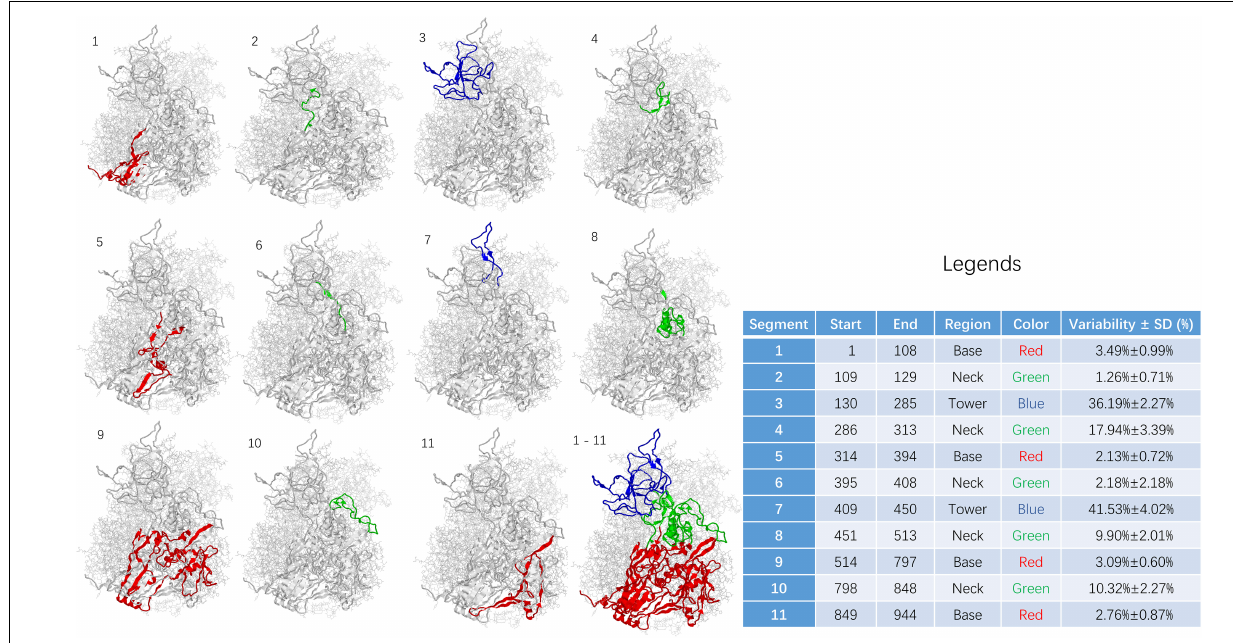
FIGURE 3 | Sequence variability among segments of adenoviral hexon. The base region including segment 1, 5, 9, and 11 was shown in RED. The neck region including segment 2, 4, 6, 8, and 10 was shown in GREEN. The tower region including segment 3 and 7 was shown in BLUE. Statistics for the table: F = 69.119 and P < 0.001.